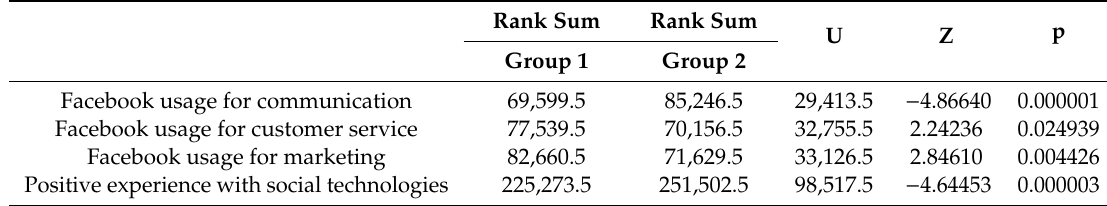
Table 2. U Mann–Whitney test results.